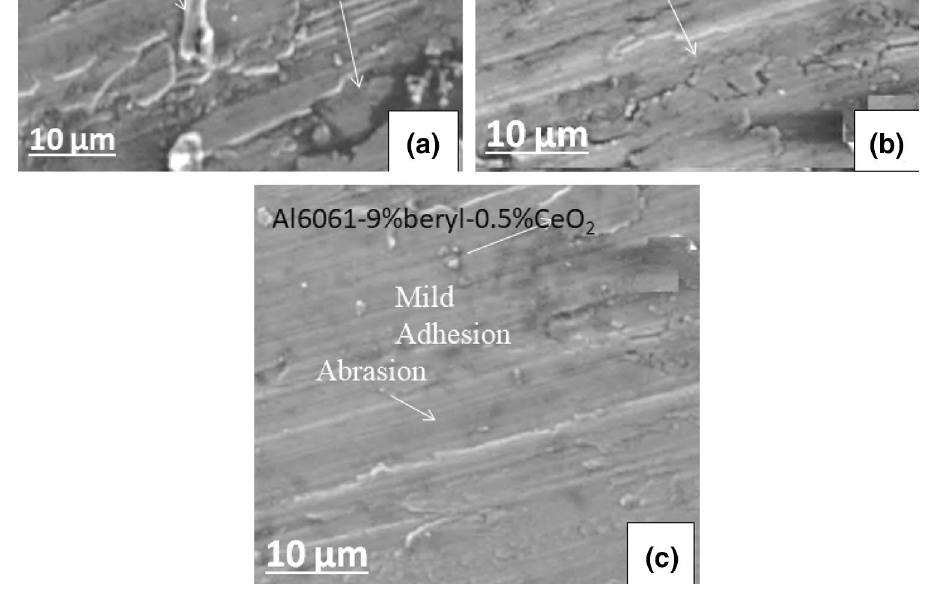
Fig. 10 Worn surfaces of ( a ) “Al6061–3% Beryl” and ( b ) “Al60619% Beryl” at 20 N load in